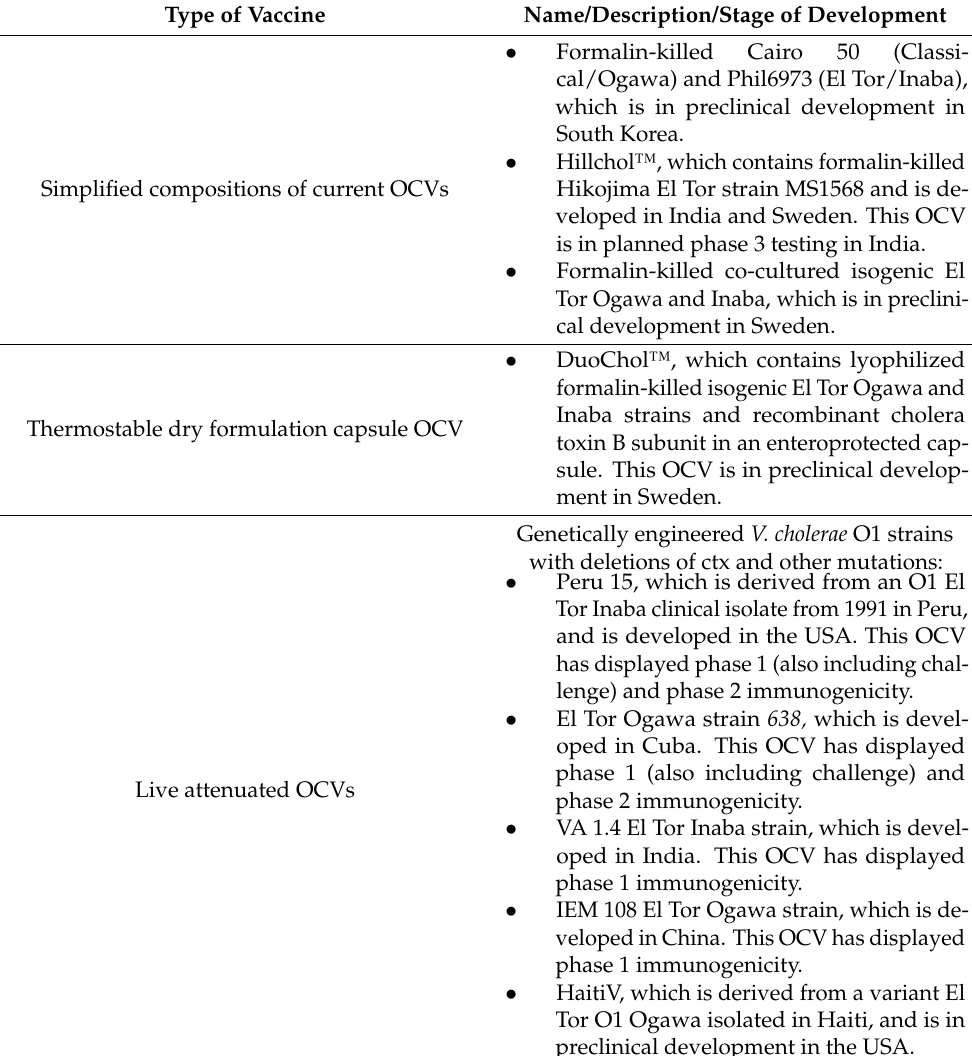
Table 3. Not yet licensed oral cholera vaccines under